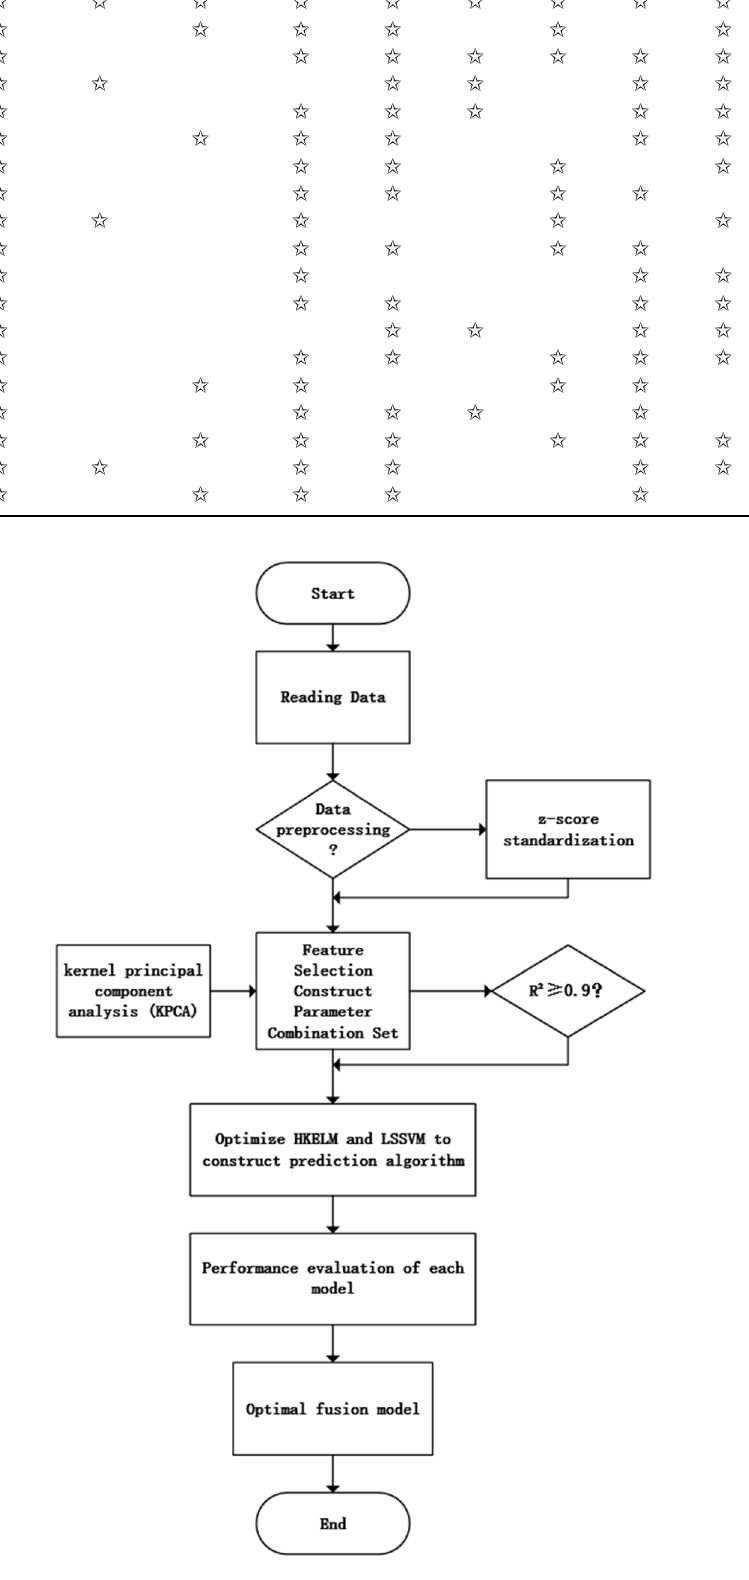
Figure 2. The flow chart for constructing the prediction Figure 2. The fl ow chart for constructing the prediction model.